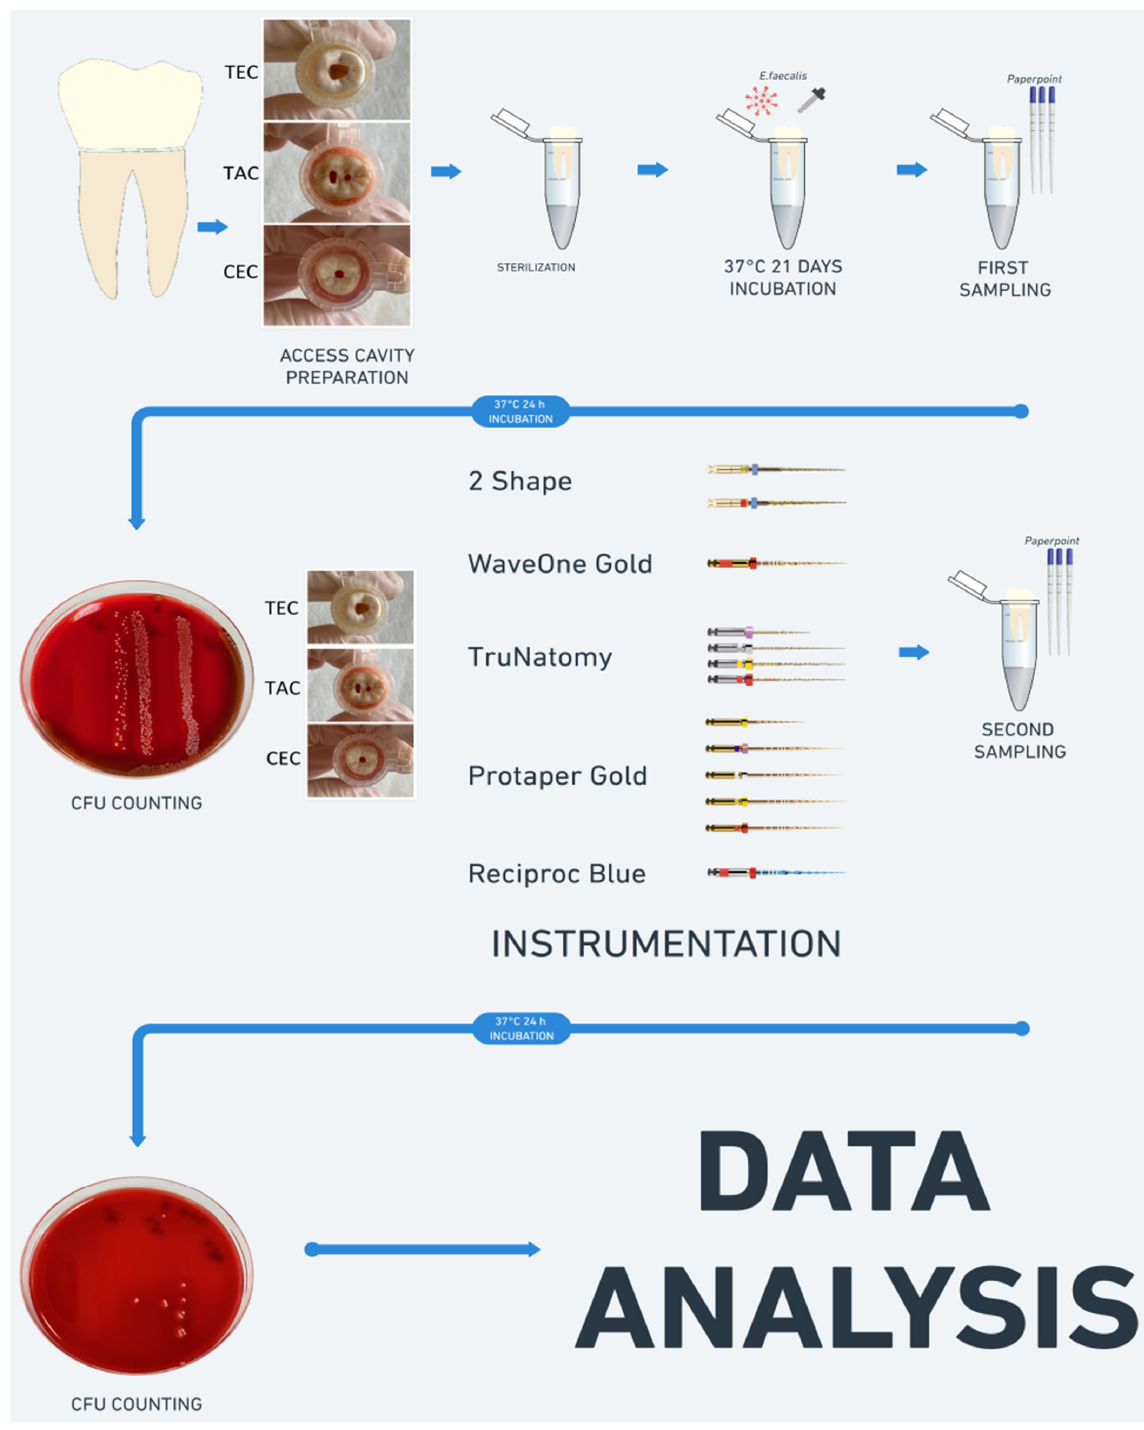
Figure 1. The schematic diagram of the methods used in this study .